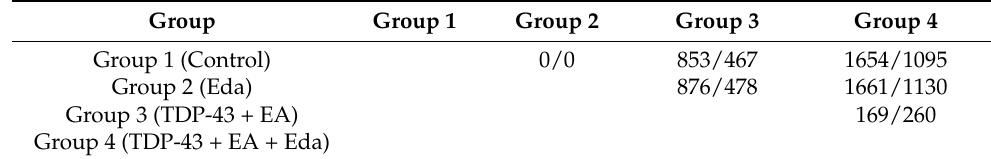
Table 1. Number of differentially expressed